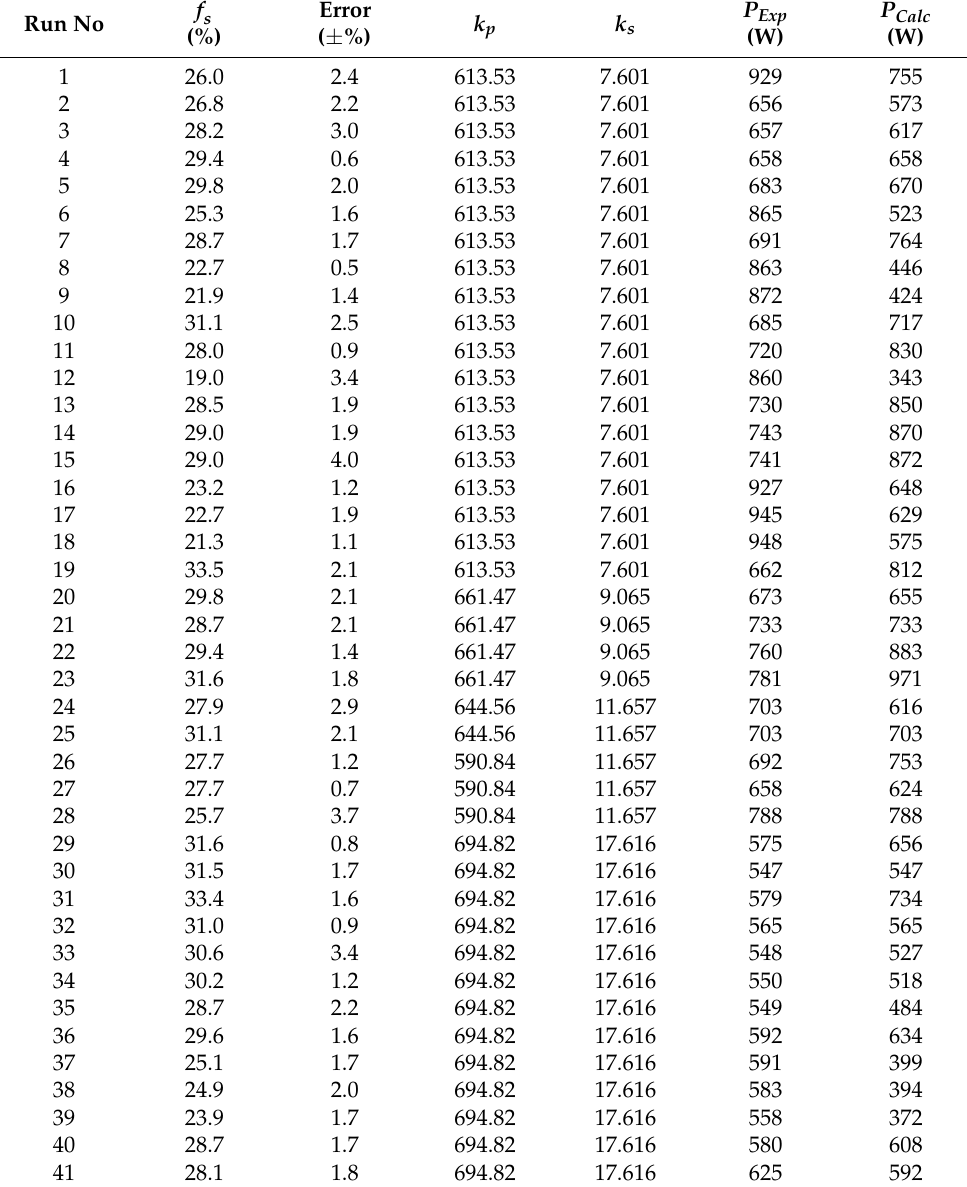
Table A2. Experimental results as solid fraction, f s and associated error from metallographic analysis, the calculated Rushton Turbine geometry factors, k p and k s , and the measured and calculated power for